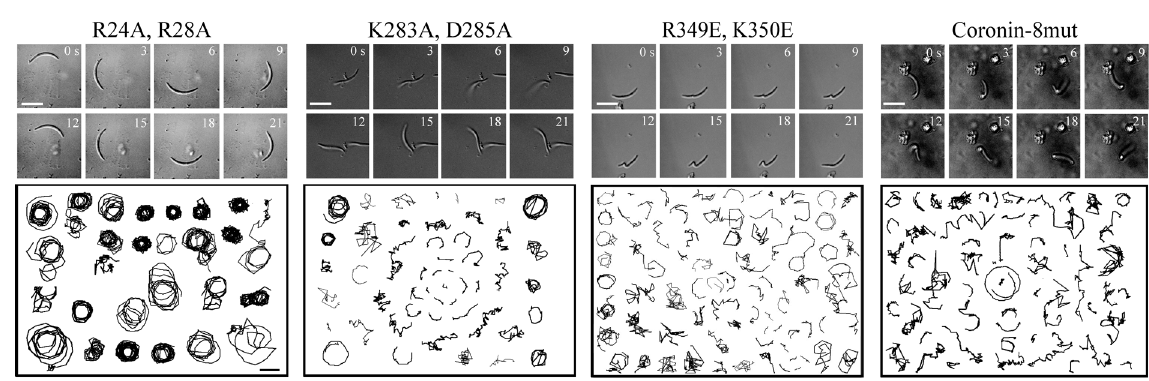
Fig 3. Mutant coronins exhibit defects in sporozoite motility. Time-lapse images and randomly selected tracks of different parasite lines expressing endogenous coronin fused to mCherry with the indicated mutations in their putative actin-binding sites. Note that R24A, R28A moves in a similar manner to WT, while the other mutants move differently and exhibit bending movements so far not seen in any wild type or mutated sporozoite, most strikingly seen in the time lapse of a sporozoites expressing the R349E, K350E mutation. A small but discernable fraction of sporozoite expressing the K283A, D285A mutation in coronin can move in persistent circles. Scale bars: 5 μ m (images), 10 μ m (tracks).